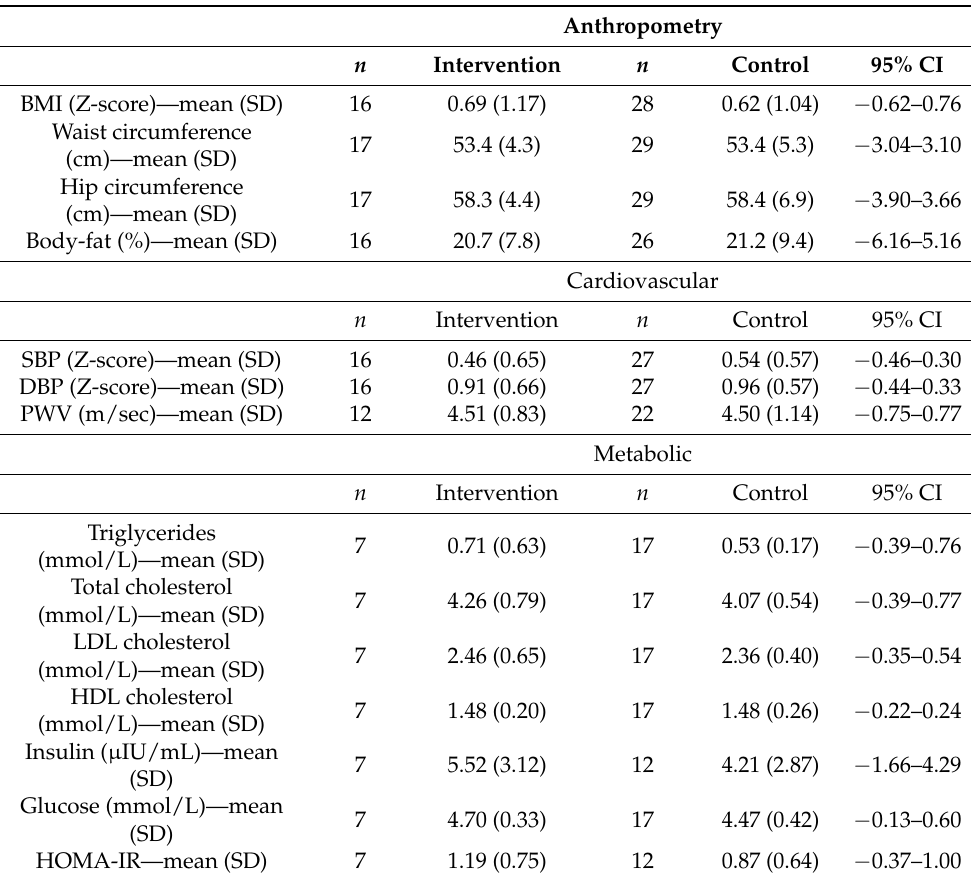
Table 2. Cardiometabolic outcome values of children of mothers from the intervention and control